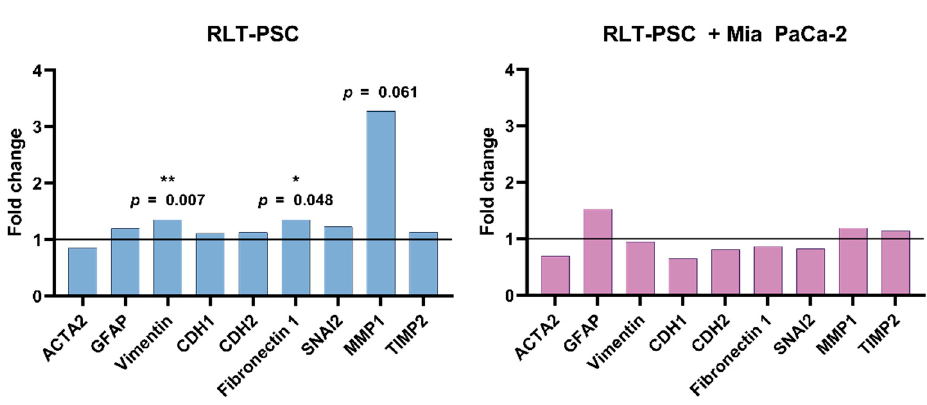
Figure 4. CAP does not alter mRNA expression of activation and ECM remodelling factors in tissue with RLT-PSC cells. mRNA was extracted from RLT-PSC and RLT-PSC + Mia PaCa-2 tissue. Data are presented in arbitrary units of the calculated relative normalized expression based on the untreated controls ( ∆∆ Cq; fold change 1 = untreated controls). Analysis done with the Bio-Rad CFX Maestro 1.1 software.